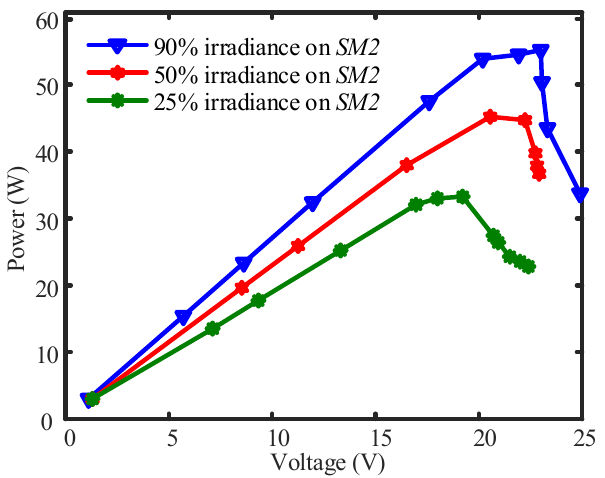
Figure 13. Experimentally achieved P-V characteristics for the proposed technique when SM2 in Figure 5 is producing 90%, 50%, and 25% of SM1 (30 W).